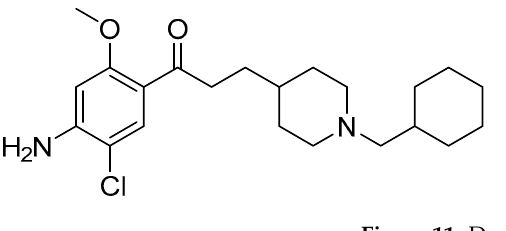
Figure 11. Donecopride.